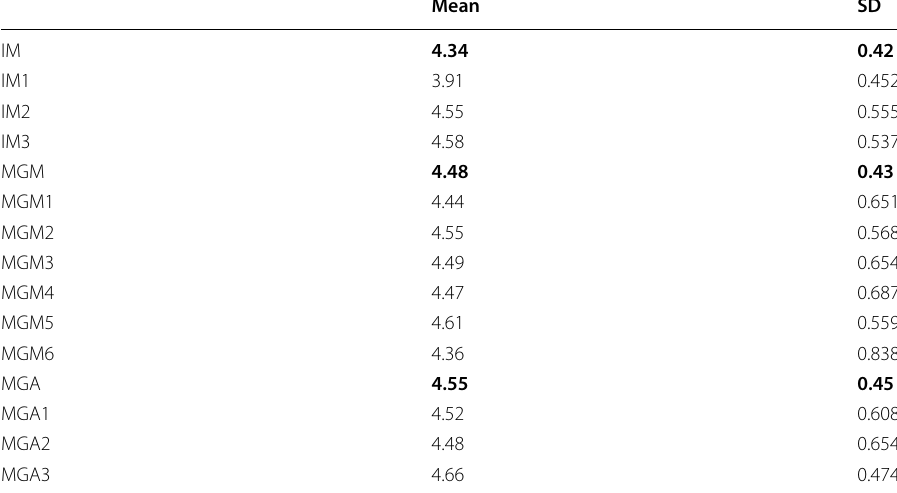
Bold is used to distinguish the three factors (IM, MGM, MGA)